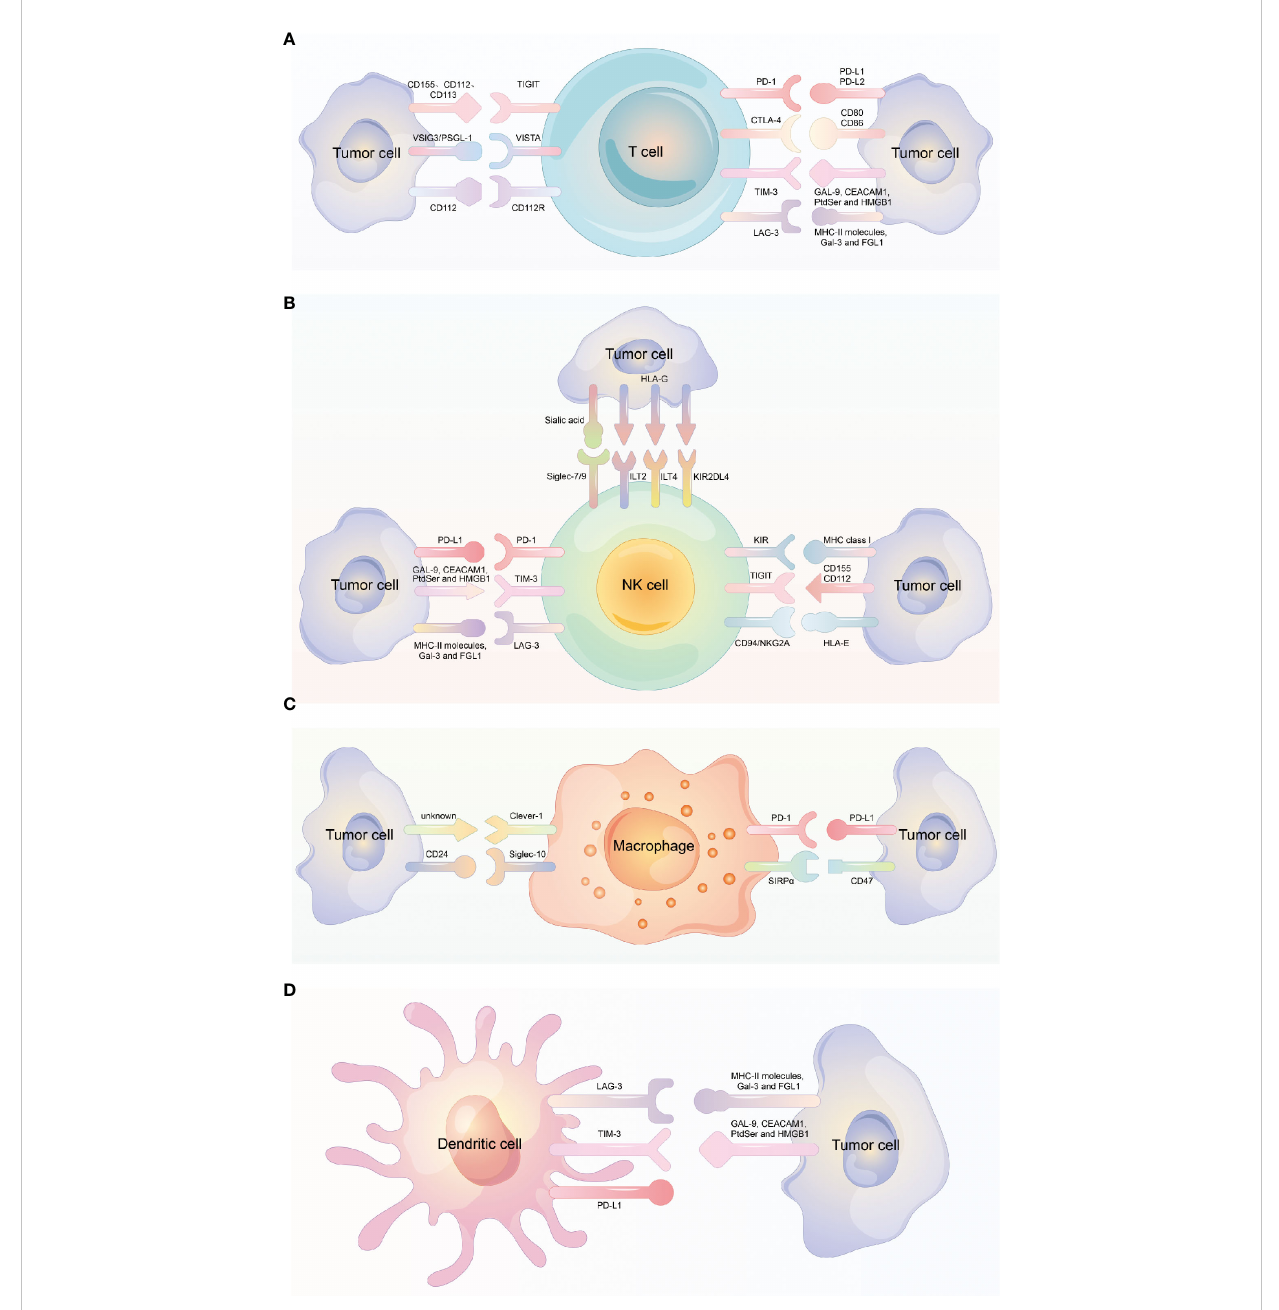
FIGURE 1 Different immune checkpoint molecules expressed on different immune cells. (A) Different immune checkpoint molecules expressed on T cell and the corresponding ligand molecules expressed on tumor cells. (B) Different immune checkpoint molecules expressed on NK cell and the corresponding ligand molecules expressed on tumor cells. (C) Different immune checkpoint molecules expressed on Macrophage and the corresponding ligand molecules expressed on tumor cells. (D) Different immune checkpoint molecules expressed on dendritic cell and the corresponding ligand molecules expressed on tumor